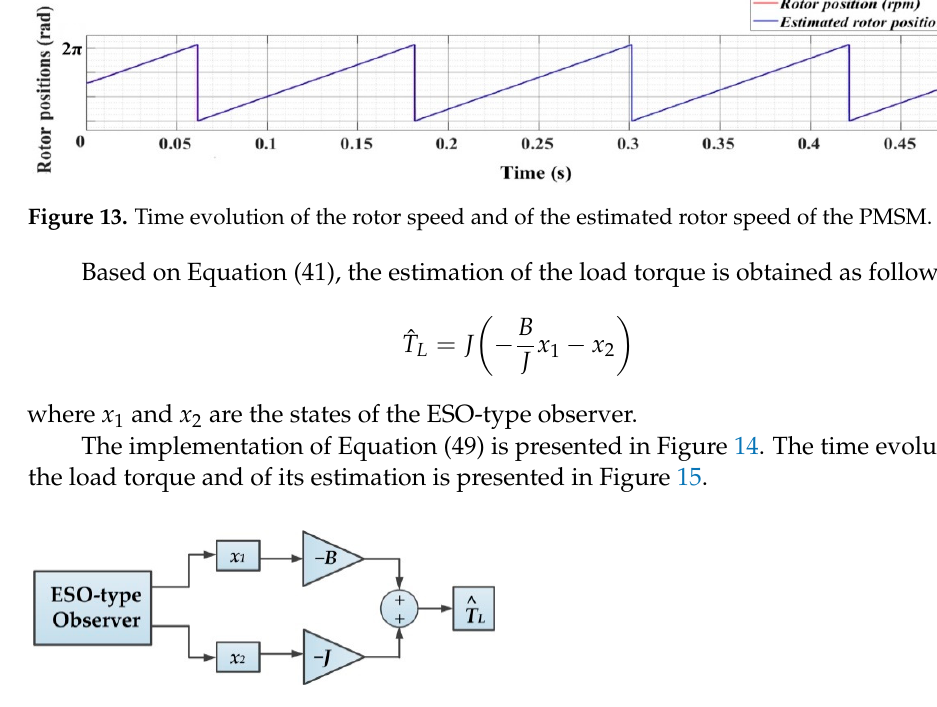
Figure 12. Block diagram of the PMSM rotor position estimation.